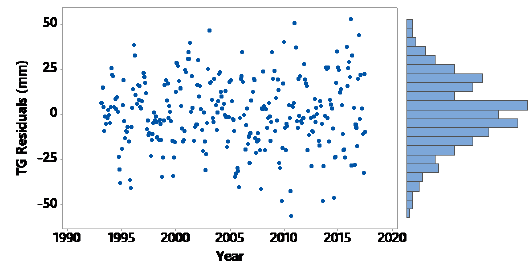
Fig. 7. TG residuals are in mm. RMSE of the residuals is 19.2